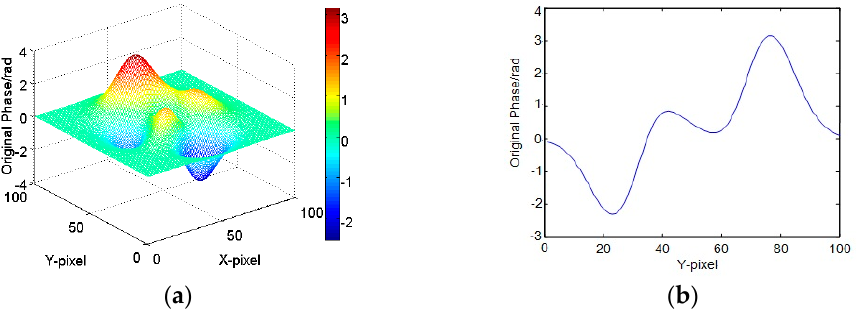
Figure 1. Original phase distribution ϕ ( x , y ) , where ϕ ( x , y ) is the Peaks function in MATLAB ( a ) Three-dimensional (3D) phase distribution; ( b ) Phase line trace along Y at X-pixel = 50 on Figure 1a.